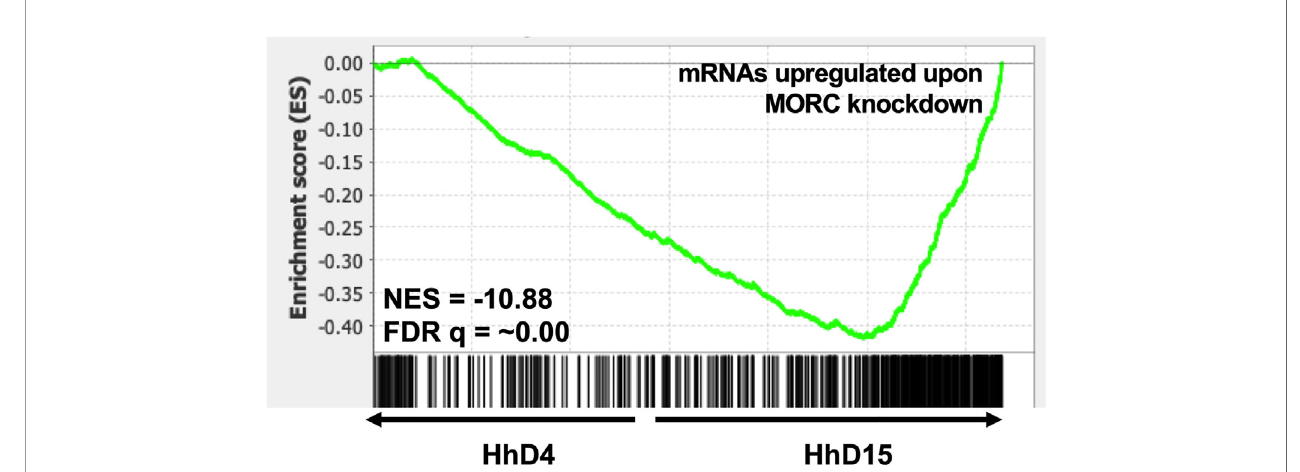
FIGURE 4 | Spontaneously developing H. hammondi transcriptional abundance is enriched for genes regulated by MORC. Preranked GSEA, comparing D4 and D15 HhEth1, ranked listed was calculated from Log 2 fold change between D4 and D15 spontaneous developing HhEth1 samples. The data used to generate this fi gure was obtained from (Sokol et al., 2018). Gene sets were created with data from (Farhat et al.,